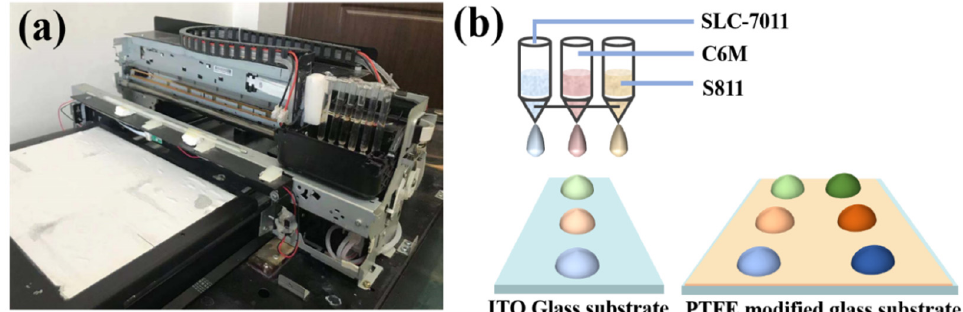
Figure 2. ( a ) The printer after being modified; ( b ) the scheme of